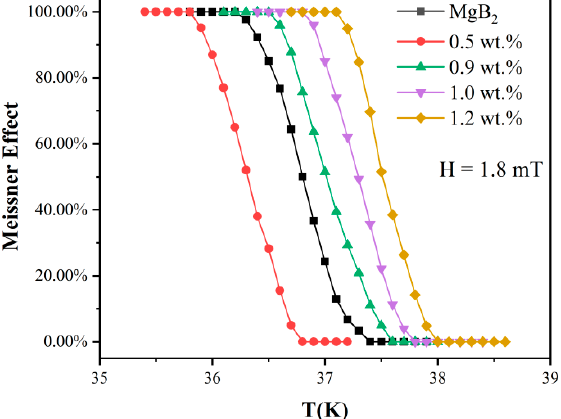
Figure 7. DC magnetization data of pure MgB 2 and MgB 2 doped with inhomogeneous